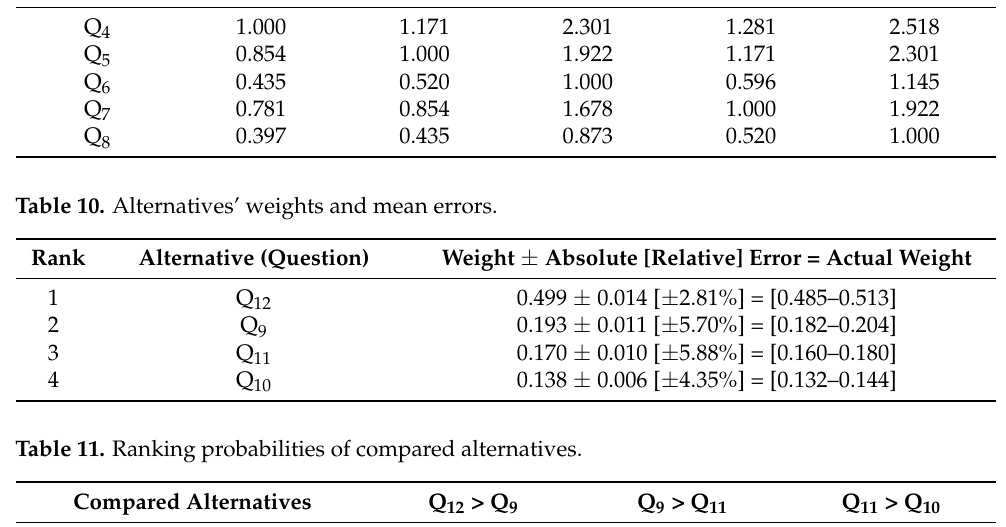
Table 12. Relative reciprocal weights for compared alternatives.